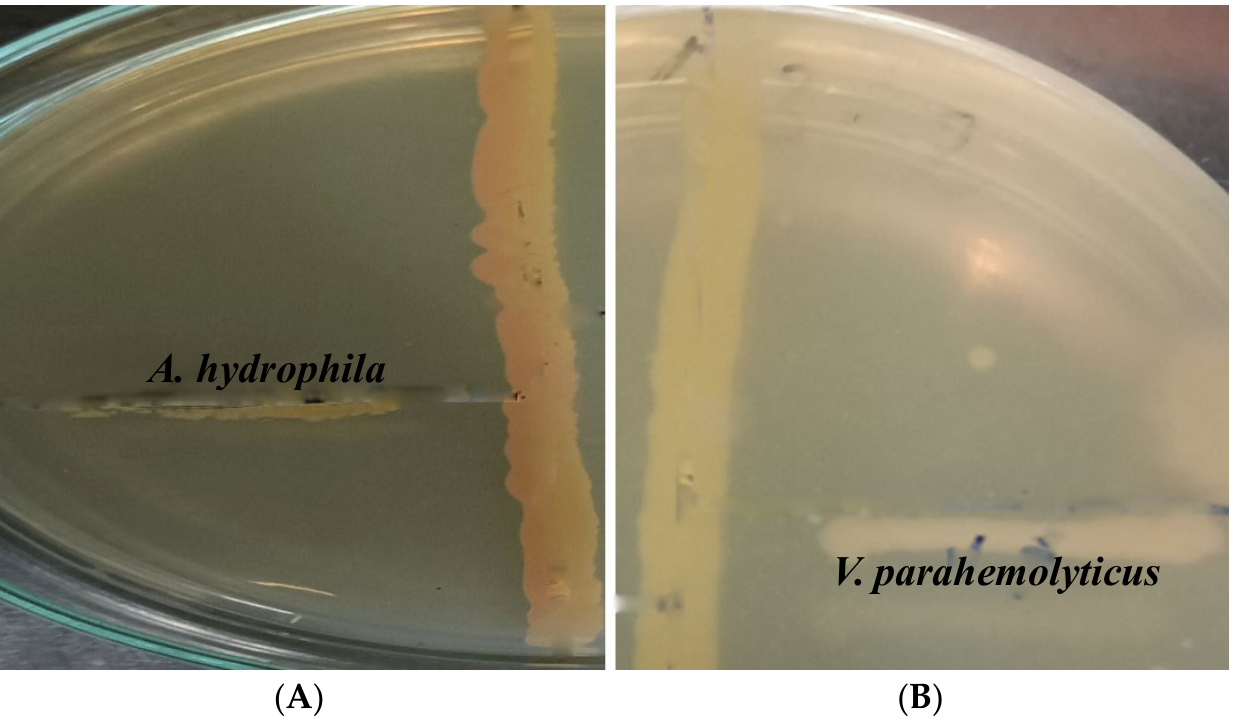
Figure 1. Primary screening of the antimicrobial activity of isolate 1 ( B. fluminensis VIT01) against selected pathogens ( A ) A. hydrophila ( B ) V. parahemolyticus.